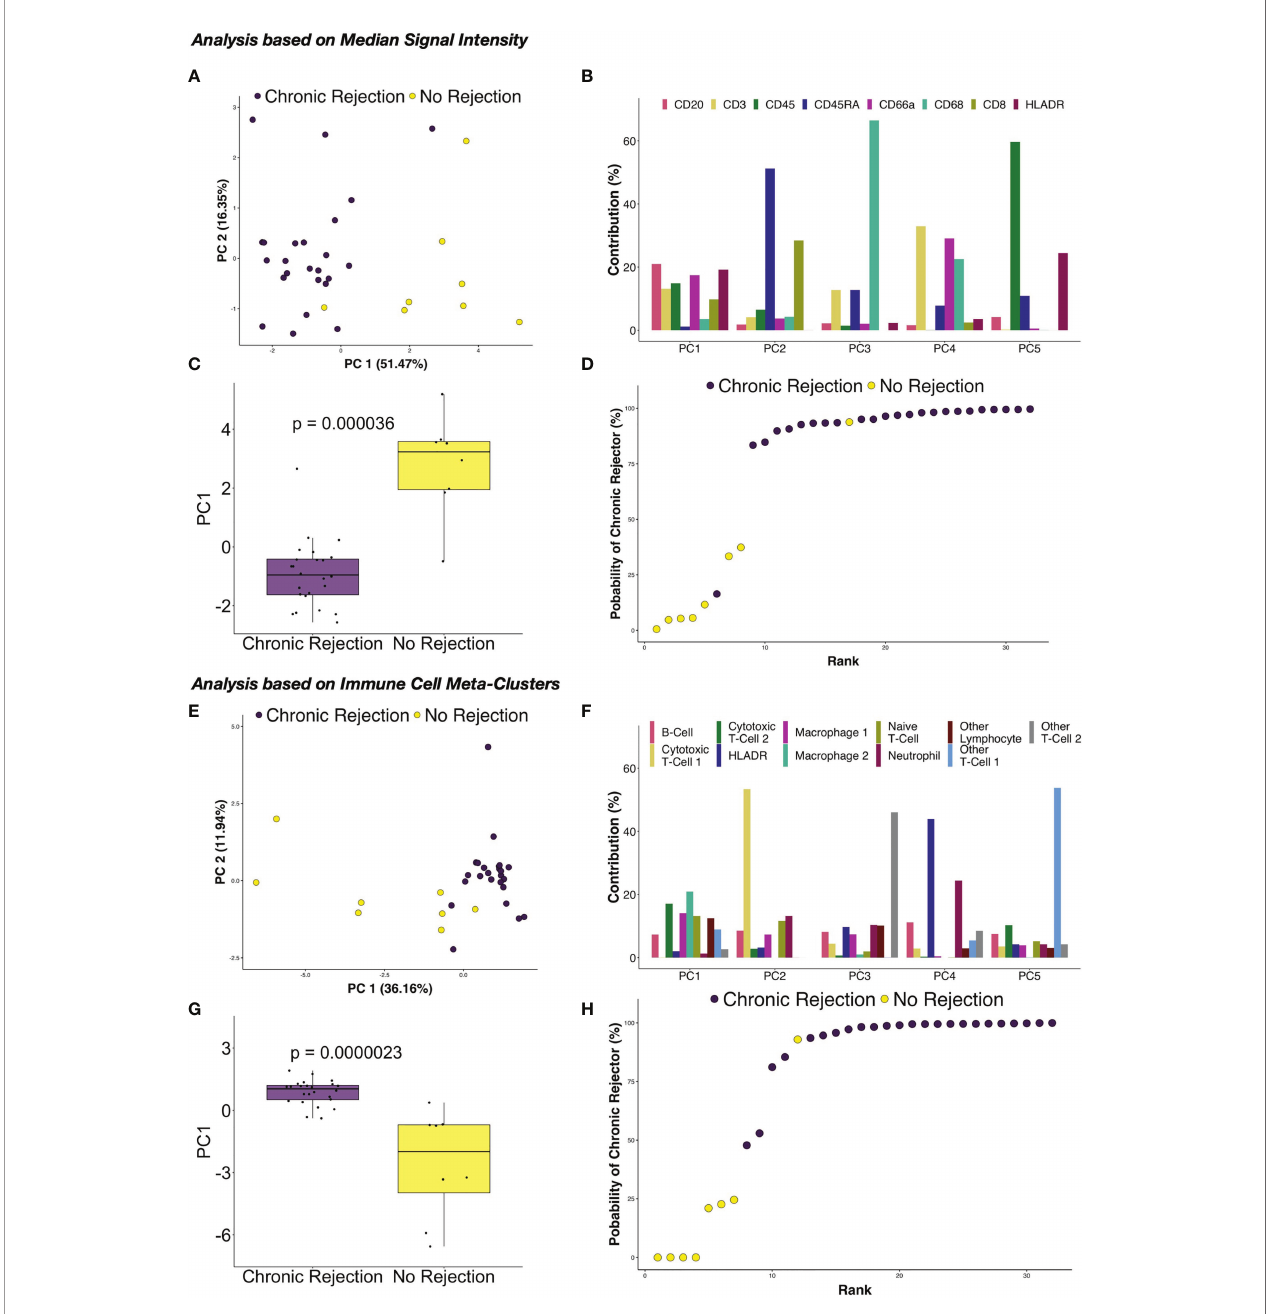
FIGURE 6 | Principal component analysis of immune marker distribution via IMC demonstrates strong correlations with chronic rejection in clinical liver biopsies. Following dimensionality reduction, tSNE plots obtained from individual regions of interest suggested that the immune milieu of chronic rejection was consistent across patient samples. (A) Principal component analysis (PCA) of median signal intensity for each IMC marker revealed that Principal Component (PC) 1 explained 51.47% of the variance across markers. (B) The relative contributions of each marker for each component demonstrate that each of the immune markers contribute to PC1, rather than one speci fi c immune population. (C) PC1 accounted for most differences between liver with no rejection and chronic rejection (Wilcoxon Rank Sum test, p=0.000036). (D) Based on a logistic regression on PC1, regions of interest from chronic rejection were correctly modeled with at least 75% probability, with only one outlier from liver with no rejection and chronic rejection samples failing to group within the model. PCA was also performed using immune meta-cluster proportions. (E) PC1 explained 36.16% of the variance across immune meta-clusters. (F) The relative contributions of each immune meta-cluster in each PC are shown, highlighting that multiple immune subpopulations contribute to PC1. (G) PC1 accounted for most differences between liver with no rejection and chronic rejection (Wilcoxon Rank Sum test, p=0.0000023). (H) Based on a logistic regression on PC1, regions of interest were modeled with the same accuracy as in (D) but with two chronic rejection samples falling close to the 50% cut